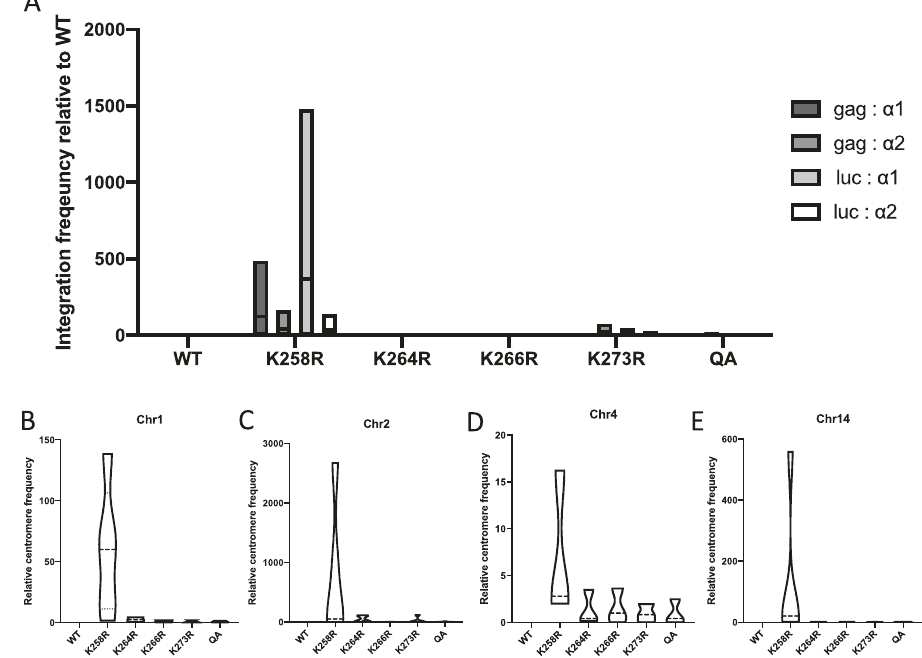
Fig. 5 Quanti fi cation of integration frequency into centromeric regions by qPCR methods. A Integration into centromeric alphoid repeat DNA was quanti fi ed using a modi fi ed Alu-gag based nested PCR approach. Two unique primers were designed complementary to an alphoid repeat consensus sequence ( α 1, α 2) and used instead of the typical Alu primer. Two primers at either end of the viral genome were used — either in the 5 ′ end of gag or in the 3 ′ UTR of the luciferase ( luc ) reporter gene. First nest PCR was performed with these four primer combinations. Shown are the results of a second nest quantitative PCR using LTR-speci fi c primers normalized to total integrated provirus levels as measured by Alu-gag PCR. Data from a minimum of three independent replicates is shown relative to WT as box plots to show the minimum, maximum and mean values. B – E Quantitative PCR using chromosome- speci fi c centromere primers. Viral LTR-host genome junctions were ampli fi ed and centromere content was subsequently quanti fi ed using qPCR with chromosome-speci fi c primers (see Table S4 for all primer sequences) and normalized to total integrated provirus levels as measured by Alu-gag PCR. Shown is the relative centromere content for each infected sample relative to WT from a minimum of two independent biological replicates done in triplicate presented as a violin plot to accurately represent the data distribution. Source data are provided as a Source Data fi